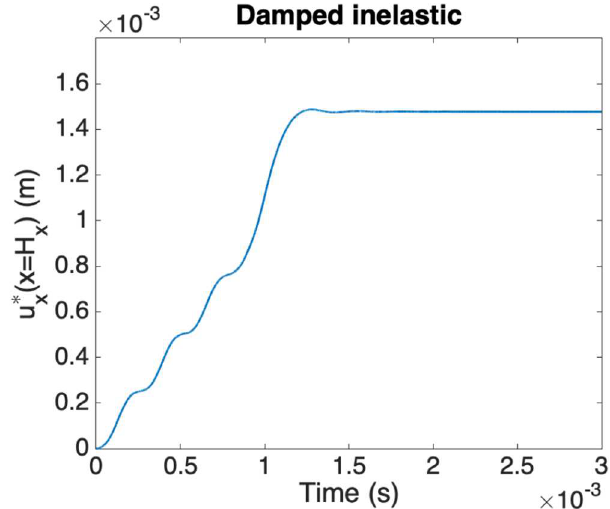
Fig. 18. Displacement of the structure right surface: u ∗ x ( x = H x ) in the inelastic case study.